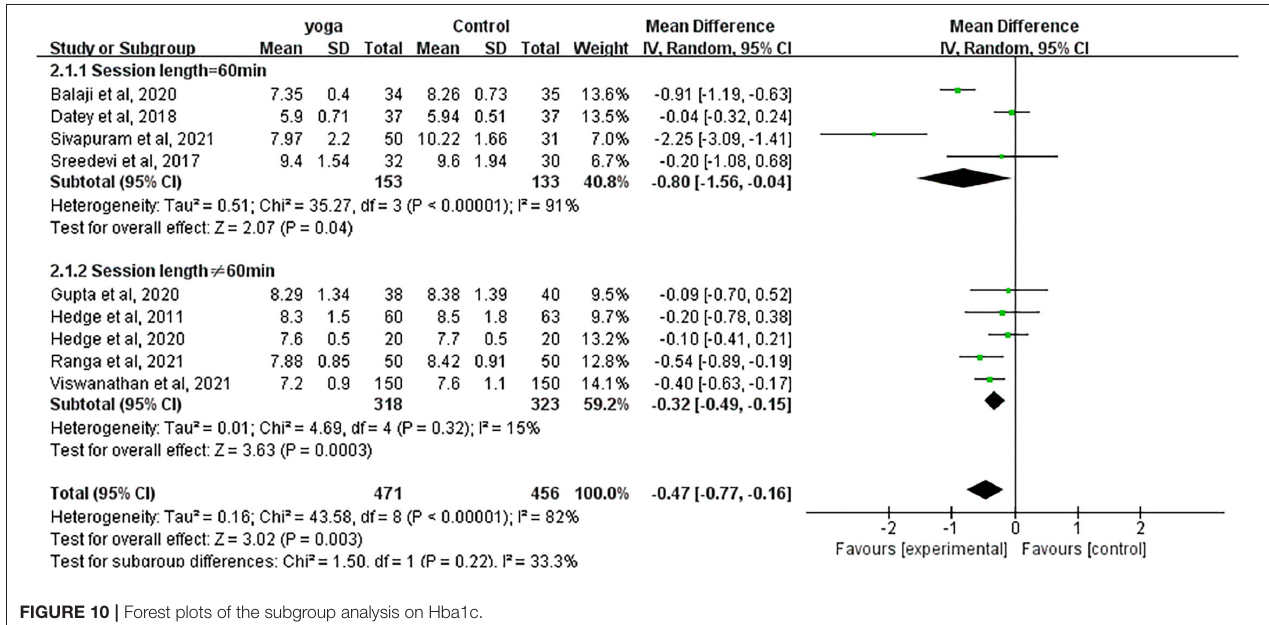
FIGURE 10 | Forest plots of the subgroup analysis on Hba1c.